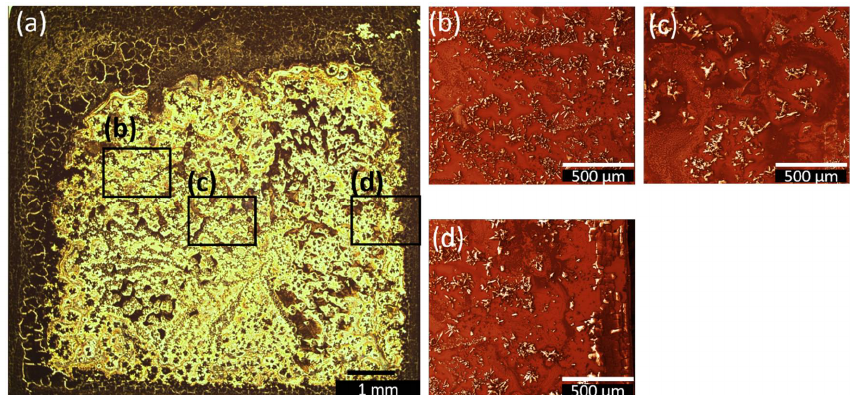
Figure 7. ( a ) Overview microscopy image for 2 –DrA–2 after complete evaporation of acetonitrile. For better resolution, SEM images with same magnification were chosen in ( b – d ) at several spots of the sample, shown after applying the image filter Gwyddion.net from Gwyddion software. The SEM images indicate areas with dendritic growth typical for diffusion-limited